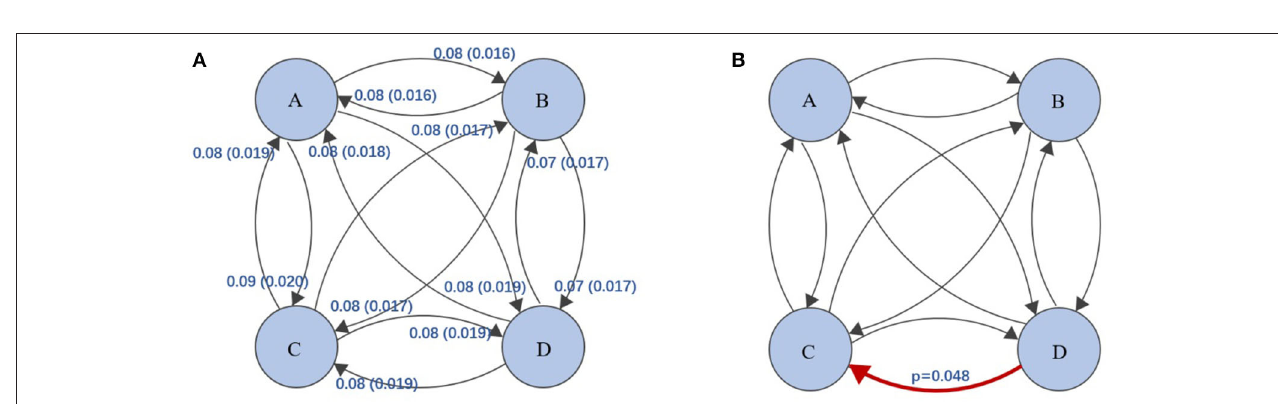
FIGURE 3 | (A) Transition probabilities and standard deviations between the four classes of EEG-ms, e.g., class A → class B, transition probability = 0.08, standard deviation = 0.016. (B) The red arrow represent the transition probability of class D to class C, and it was significantly positively correlated with the empathy score ( p -values corrected for multiple comparisons using Bonferroni). The level of significance was set to p < 0.05.